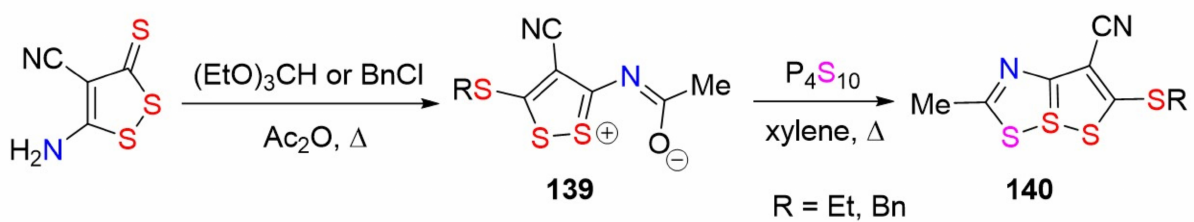
Scheme 81. Alkylation of 4-cyano-5-amino-1,2-dithiol-3-thione. 3.10. Synthesis of 3-alkylidene-3H-1,2-dithioles Knoevenagel reactions of substituted 3 H -benzo[1,2]dithiole-3-thiones with